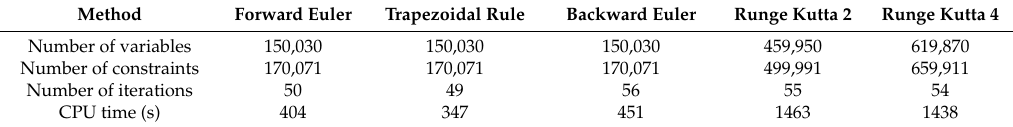
Table 3. Comparison of the common methods used in TSCOPF with the Runge Kutta methods.